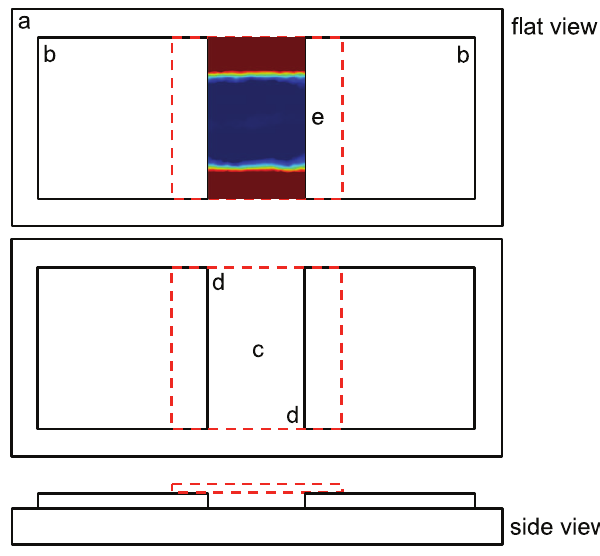
Figure 1. The measurement locations within the observation chamber. (a) Microscope slide, (b) cover slips, (c) center recordings, (d) edge recordings. A 3D numerical model depicts how oxygen diffuses from the top and the bottom of the coverslip labelled (e). Red depicts high oxygen concentrations with a vertical length of 5250 m m, whilst the blue depicts low oxygen concentrations. The chamber has a vertical length of 26,250 m m. The red dashed line illustrates the chamber cover, which sits on top of two cover slips.